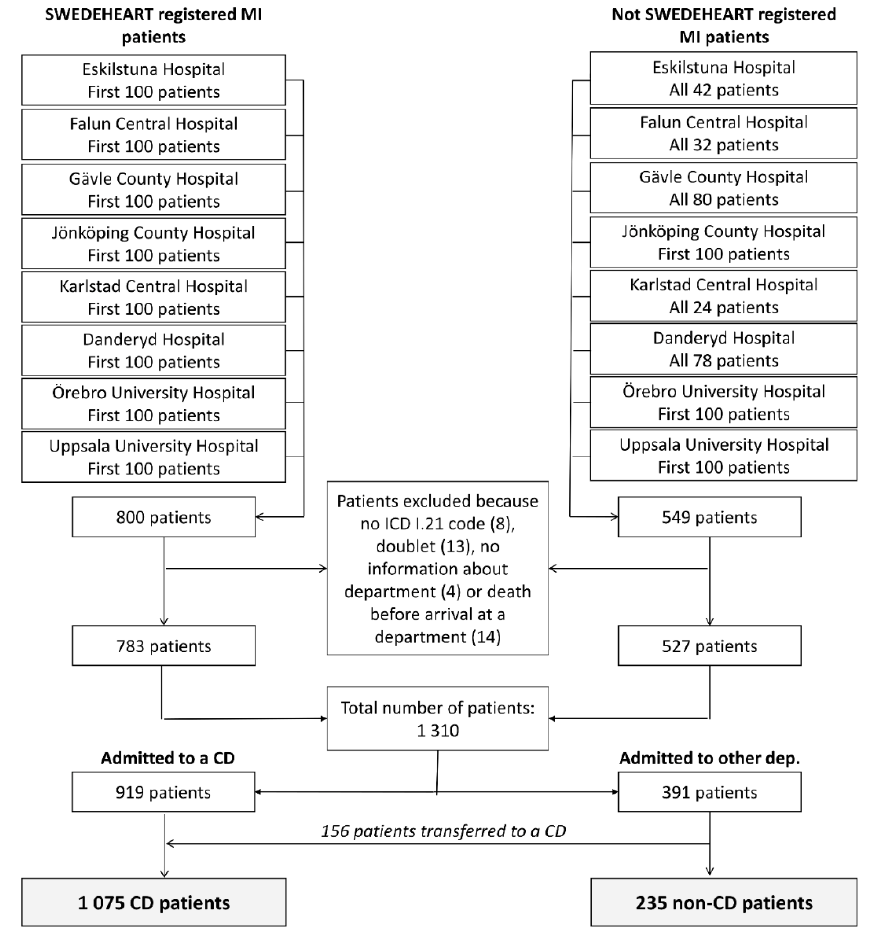
Figure 1. Patient selection process. CD—cardiology department.